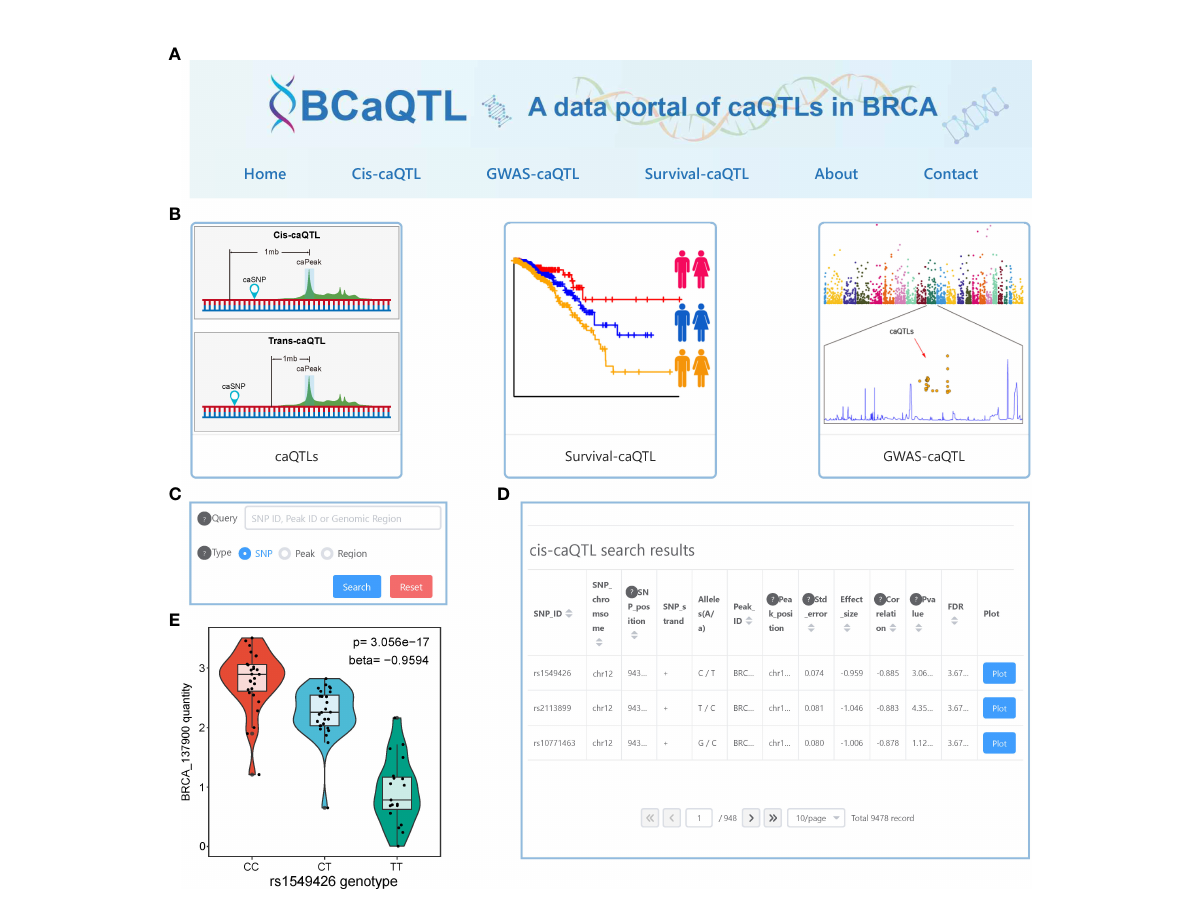
FIGURE 7 Interface of BCaQTL data portal. (A) Browser bar in BCaQTL. (B) Modules of cis-caQTL, GWAS caQTL, and survival caQTL. (C) The interface of the quick search panel. (D) An example of search results of the cis-caQTL dataset. (E) An example of the box plot shows the difference in chromatin accessibility between genotypes embedded in the search